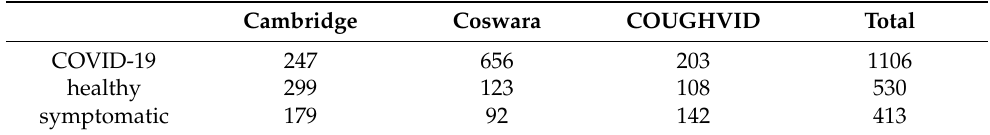
Table 2. Number of audio files after